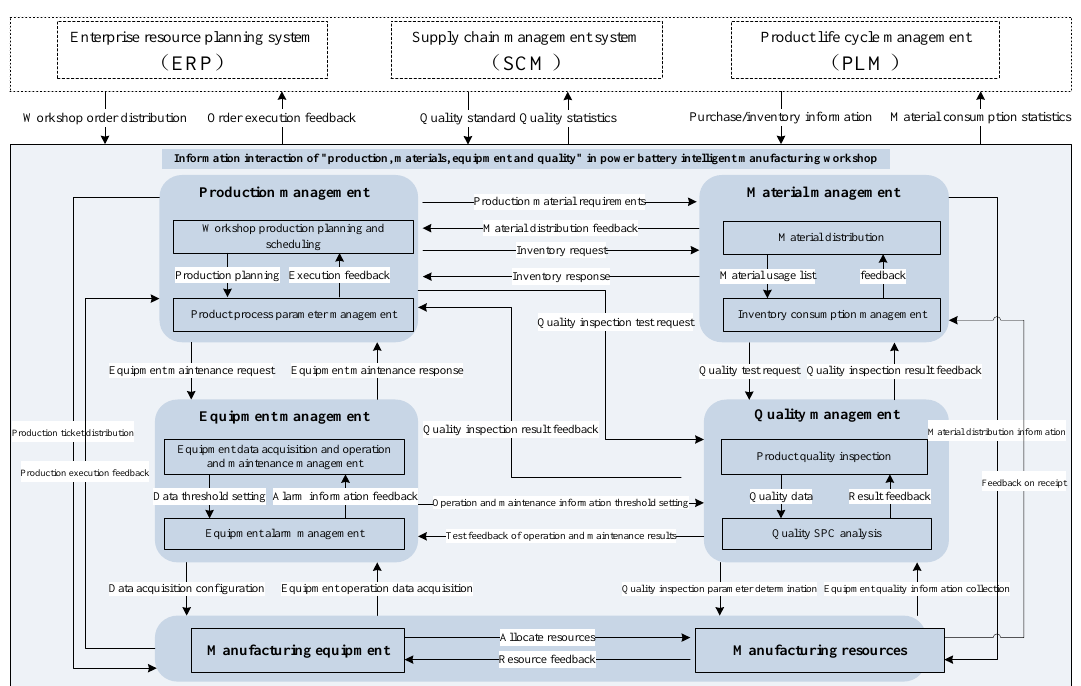
Figure 3. Information interaction of main functions in lithium ion battery intelligent manufacturing workshop.